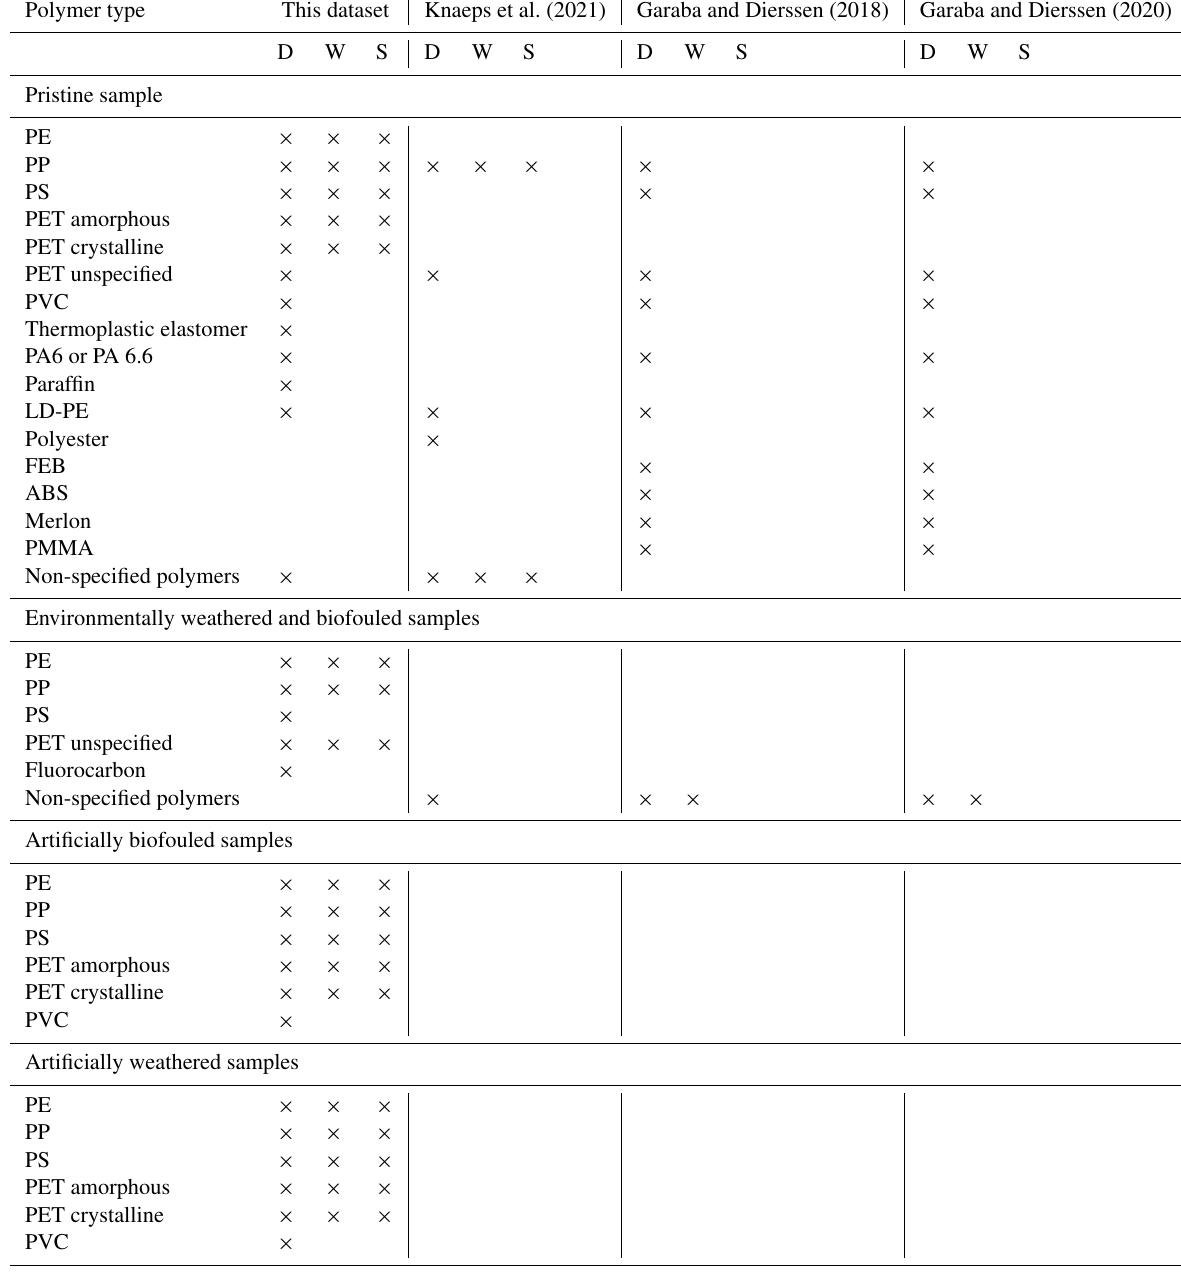
Table 1. Comparison of polymers and conditions analyzed in this dataset and in the literature. (D: dry; W: wet; S: submerged; PE: polyethy- lene; PP: polypropylene; PS: polystyrene; PET: polyethylene terephthalate; PVC: polyvinyl chloride; PA6: polyamide 6; PA 6.6: polyamide 66; LD-PE: low-density polyethylene; FEB: fluorinated ethylene propylene Teflon; ABS: terpolymer lustran 752; and PMMA: polymethyl